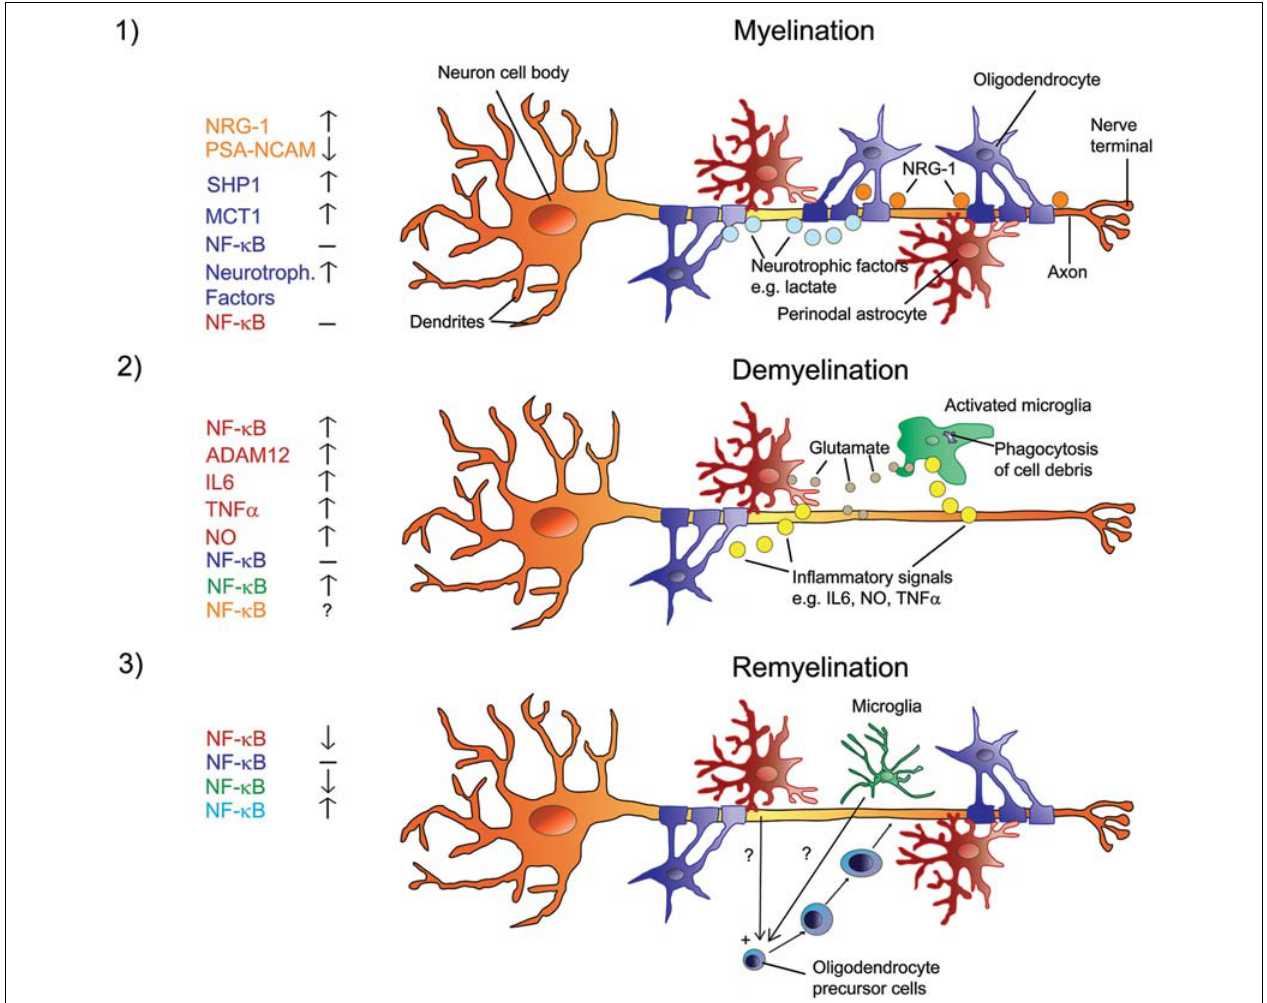
FIGURE 1 | Signals in the regulation of myelination, de- and remyelination in the CNS with a focus on NF- κ B. Myelination involves a sequence of orchestrated steps, where PSA-NCAM is downregulated in neurons and astrocytes, and neurons release several growth/trophic factors such as NRG-1 and regulate oligodendrocyte survival and maturation by upregulating SHP1. Oligodendrocytes provide trophic support to axons and promote their viability via upregulation of MCT1 and the release of lactate. There is no activation of NF- κ B in astrocytes or oligodendrocytes (1) . When myelinated axons undergo demyelination, myelin debris is phagocytized by microglia. Resident astrocytes and